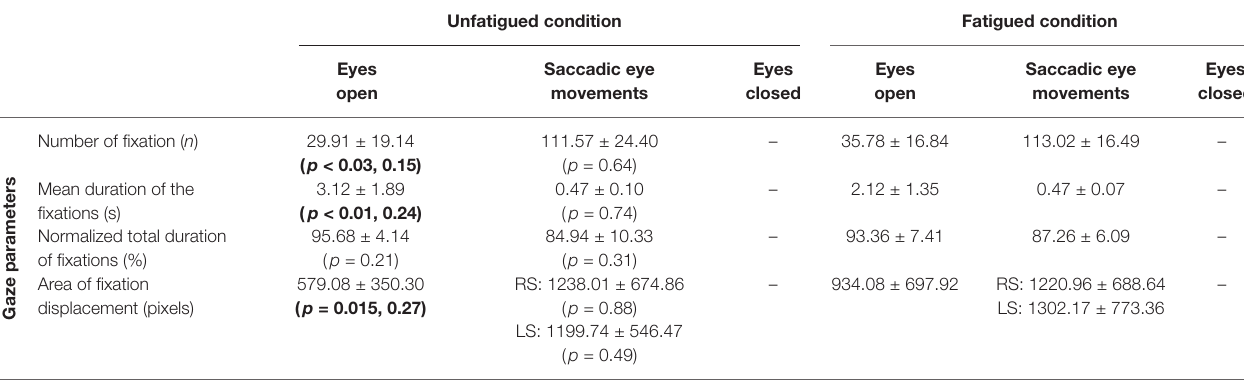
TABLE 2 | Means and standard deviations of gaze parameters for eyes open and saccadic eye movements before and after ankle muscle